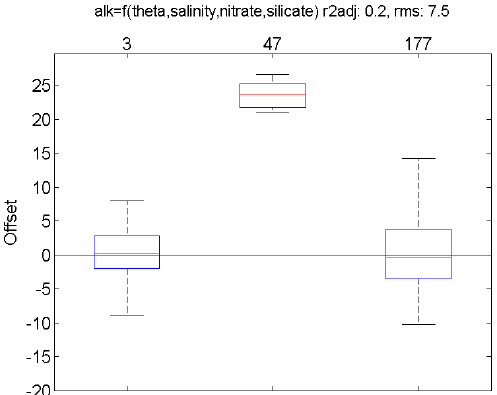
Figure 7. MLR results for TA in the Amundsen Basin (o ff sets in µ molkg − 1